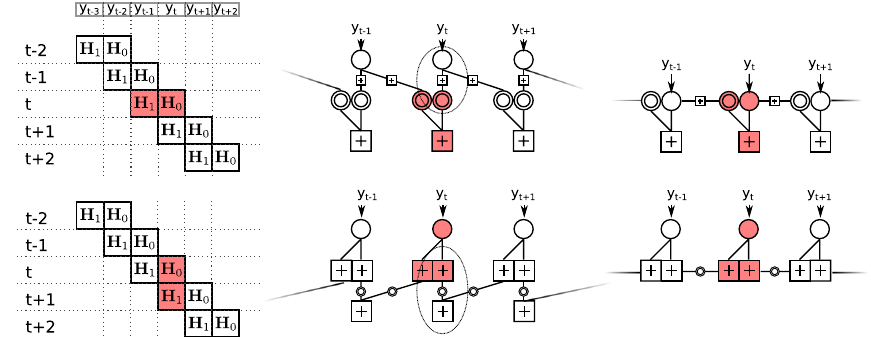
Fig. 2 Illustration of the node splitting for row- and column-wise